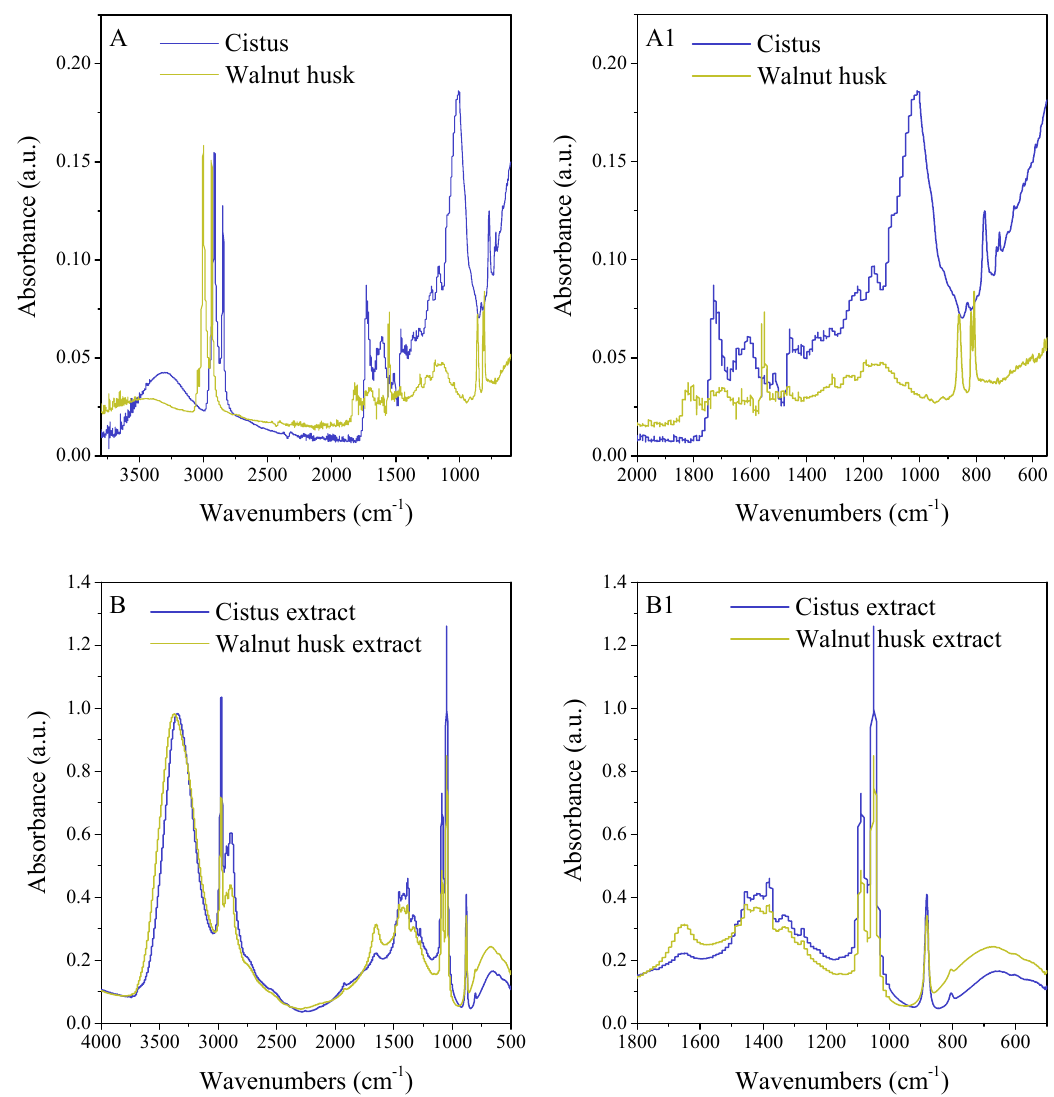
Figure 2. The FTIR spectra of plant materials ( A , A1 ) and extracts of Cistus and walnut husk ( B , B1 ).